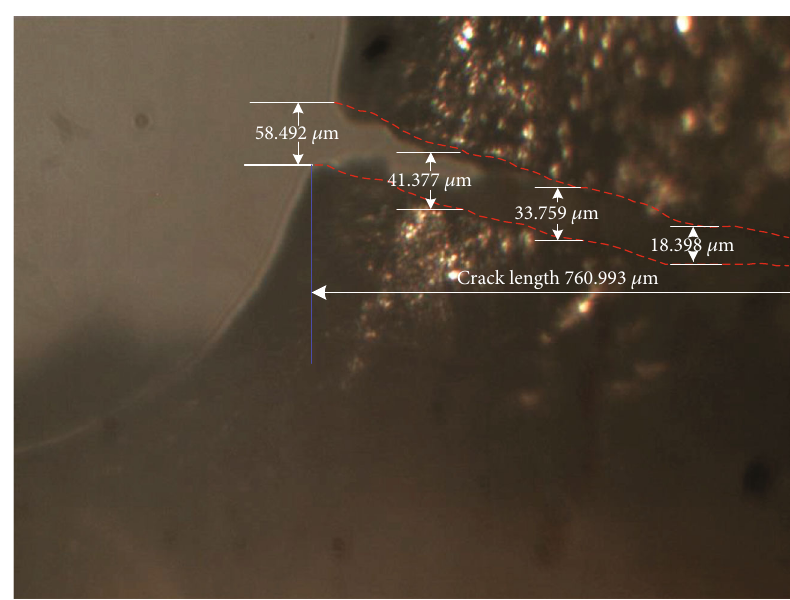
Figure 19: The corner crack at the leading edge of the specimen in the fatigue